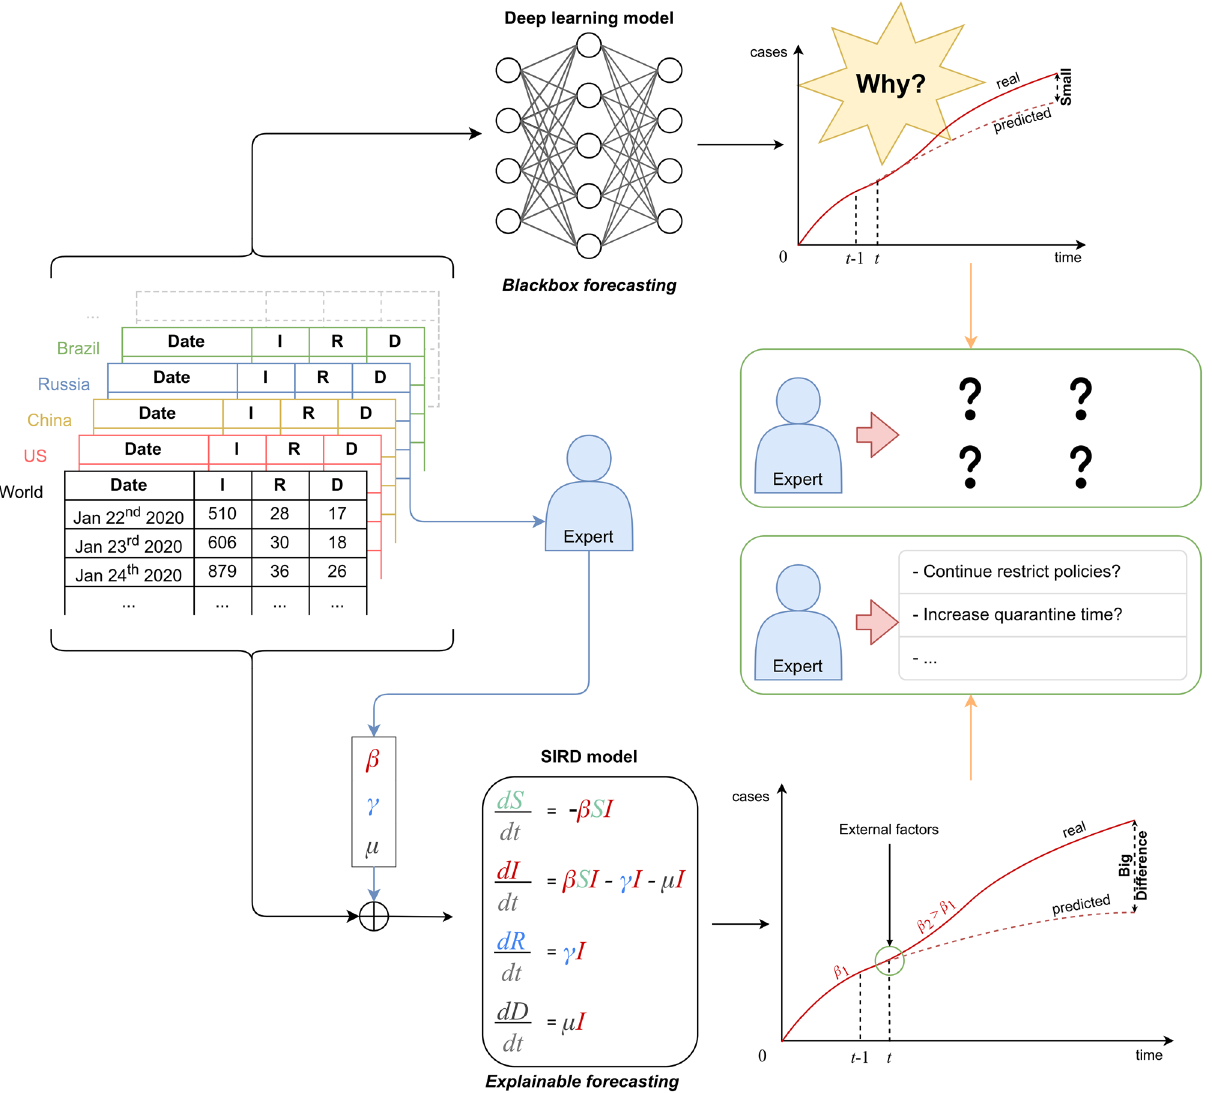
Figure 1. Illustration of the usage of deep learning and explainable model for COVID-19